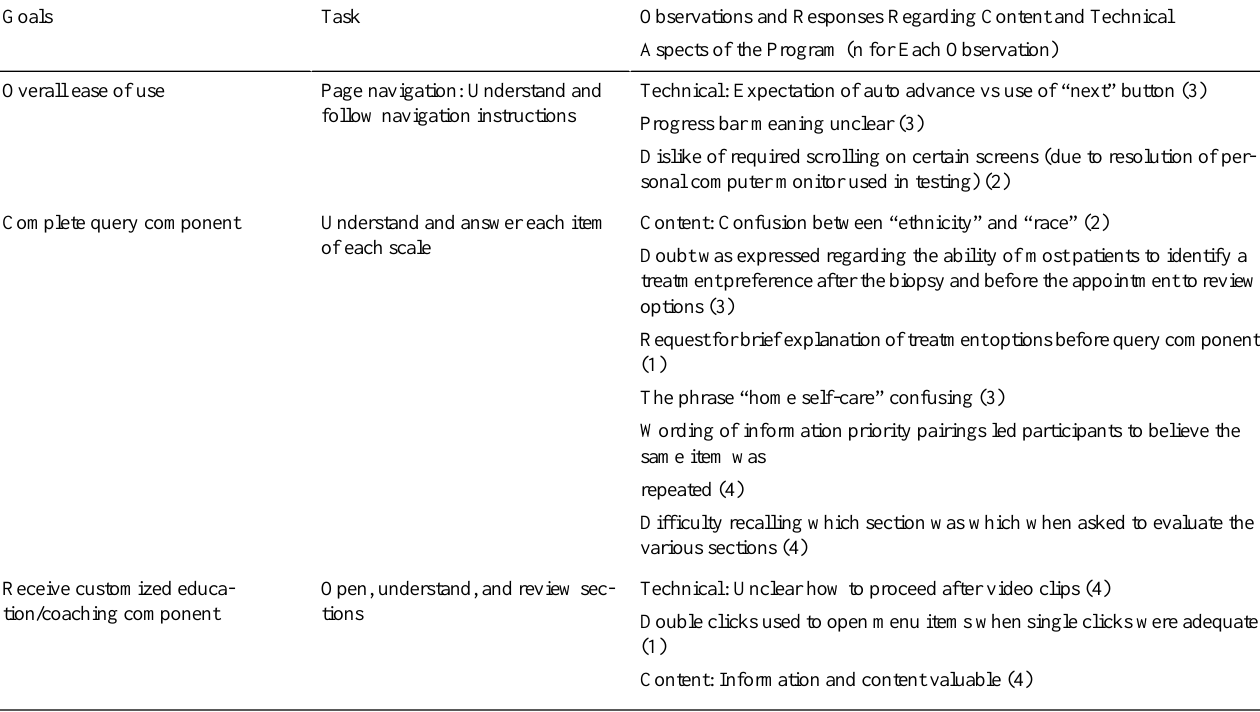
Table 3. Summary of participants’responses and observations during prepilot usability testing (N=4) Observations and Responses Regarding Content and